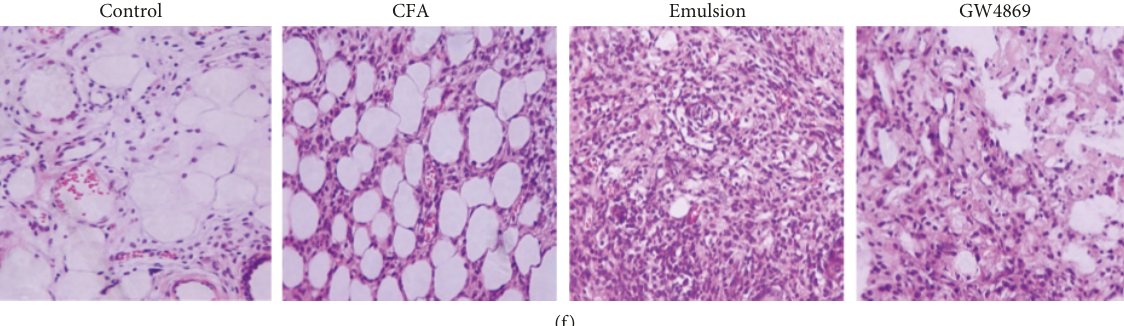
Figure 4: AKT-mTOR signaling pathway activation was detected in PCM, and inhibiting exosome secretion reduced in fl ammation in vivo. (a) The expression of PIK3K, AKT, p-AKT, p-mTOR, HSP90AA1, and EEF2 was detected in PCM tissue sections by immunohistochemical staining. (b) Immunohistochemical staining scores were analyzed by the Mann-Whitney U test. There were no statistical di ff erences for PIK3K and AKT in PCM tissues compared with NC tissues, while p-AKT and p-mTOR were overexpressed and HSP90AA1 and EEF2 were downexpressed in PCM tissues. ∗ p < 0 001 versus NC groups. (c) Western blots analyze changes of PI3K-Akt-mTOR pathway- related proteins. (d) Densitometric quanti fi cation for the changes of PI3K-Akt-mTOR pathway-related proteins was measured by QUANTITY ONE software. All values are expressed as the mean ± SD . ∗ p < 0 05 versus NC groups. (e, f) Pathological changes were detected by HE staining and inhibition of exosomes secretion by GW4869 signi fi cantly inhibited in fl ammatory cell in fi